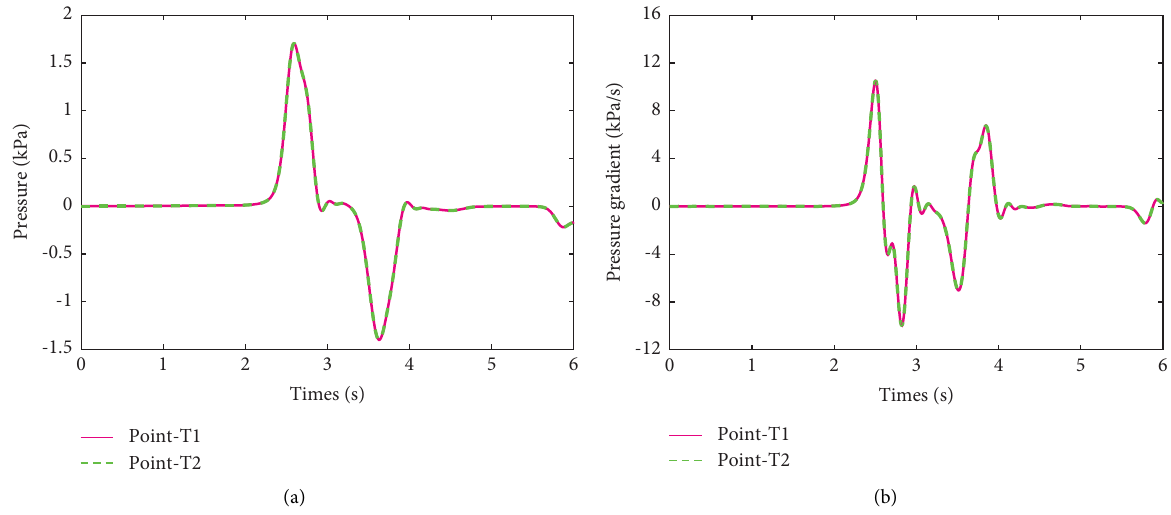
Figure 6: Comparison of initial compression waves in the same plane. (a) Pressure. (b) Pressure